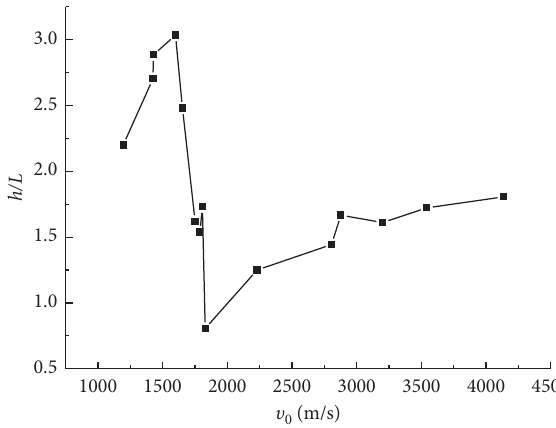
Figure 1: The curve of DOP vs. impact